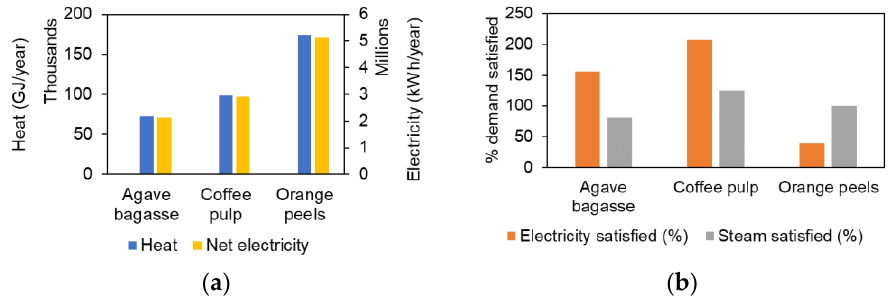
Figure 5. Results of the bioenergy simulation module for: ( a ) Bioenergy production and ( b ) demand satisfaction of steam and electricity in the tequila, coffee and orange processes using agave bagasse, coffee pulp and orange peels, respectively.